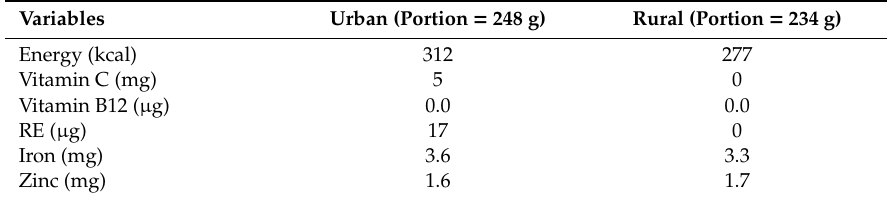
Table 2. Energy and nutrients of one regular portion of school meal (calculated in NutriSurvey © ).